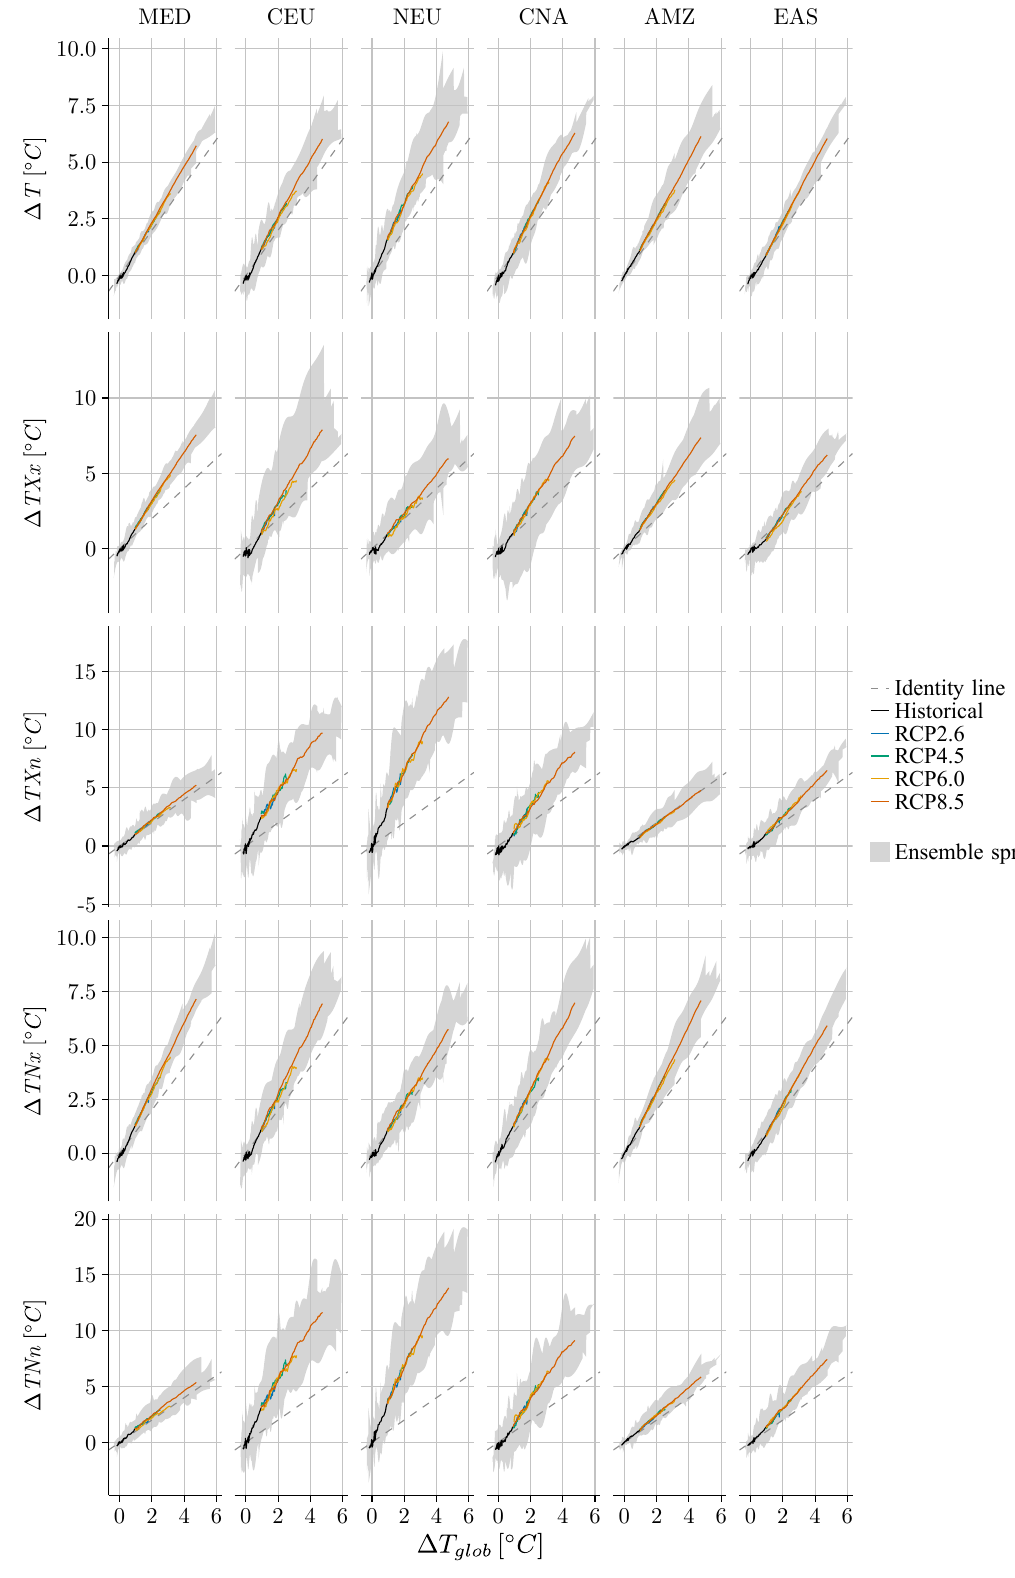
Figure 3. Functional relationships with global mean temperature for the indices (cid:49)T , (cid:49)T Xx , (cid:49)T Xn , (cid:49)T Nx , and (cid:49)T Nn , based on CMIP5 simulations of ensemble member r1i1p1 and averaged over the SREX regions MED, CEU, NEU, CNA, AMZ, and EAS. See Table 2 for a description of the